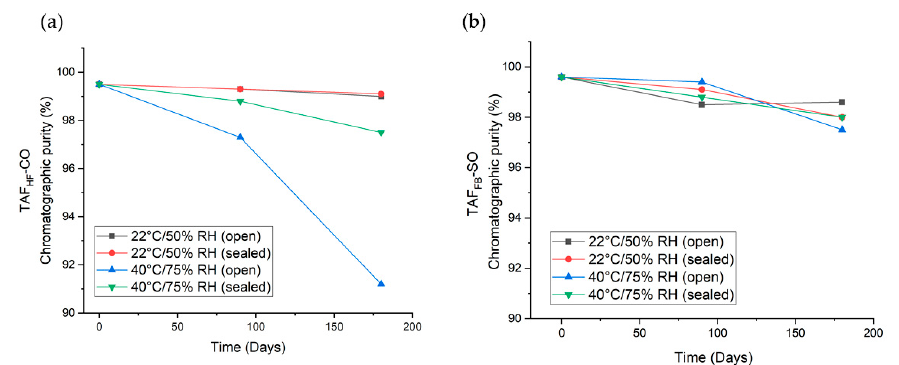
Figure 8. High-performance liquid chromatography (HPLC) chromatographic purity profile of 2:1 TAF HF -CO ( a ) and 2:1 TAF FB -SO ( b ) implants stored in open and closed foil pouches at 22 °C/50% RH and 40 °C/75% RH over 6-months.